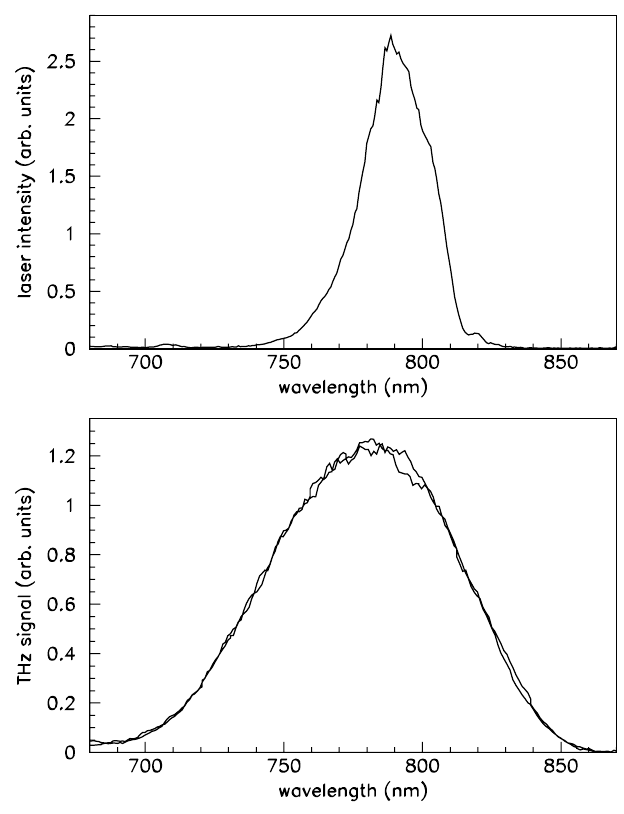
FIG. 2. Laser spectrum (top) and intensity of THz radiation from energy-modulated electrons for several scans of the reso- nant modulator wavelength